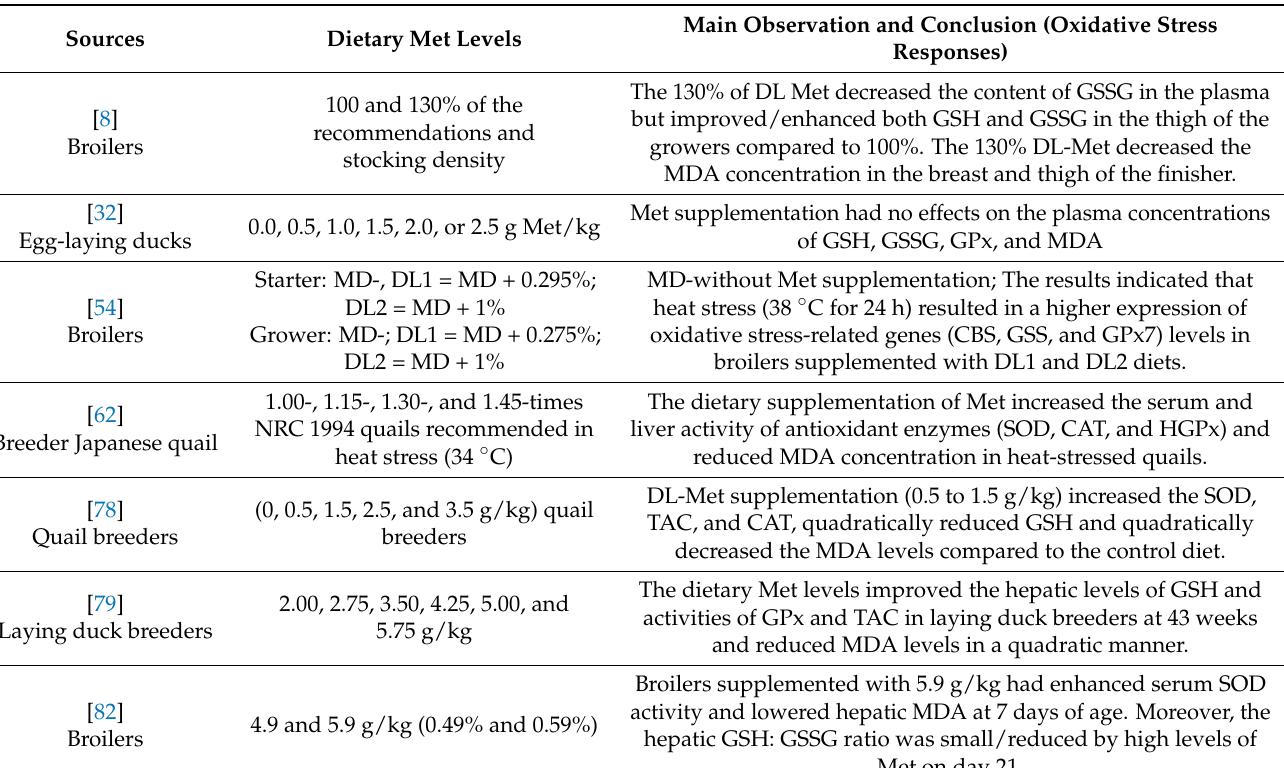
Table 4. Effects of dietary Met supplementation at different levels on the antioxidant status of